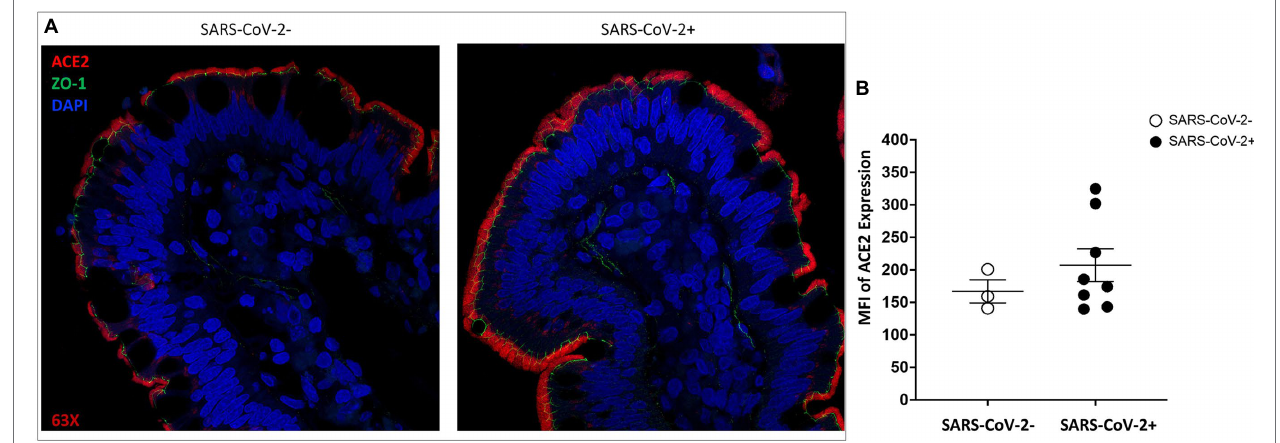
FIGURE 3 | ACE2 expression is retained in the gut epithelium of SARS-CoV-2 infected rhesus macaque. Representative images of ACE2 expression ACE2 (red) and ZO-1 (green) in villus epithelium of (A) uninfected and SARS-CoV-2 infected ileum tissues by fluorescent immunostaining. Cell nuclei are identified by DNA staining (DAPI) in blue. Magnification: 63x. (B) Mean fluorescence intensity (MFI) semi-quantification of ACE2 expression levels in ileum tissues of uninfected ( n = 3) and SARS-CoV-2 infected ( n = 8) rhesus